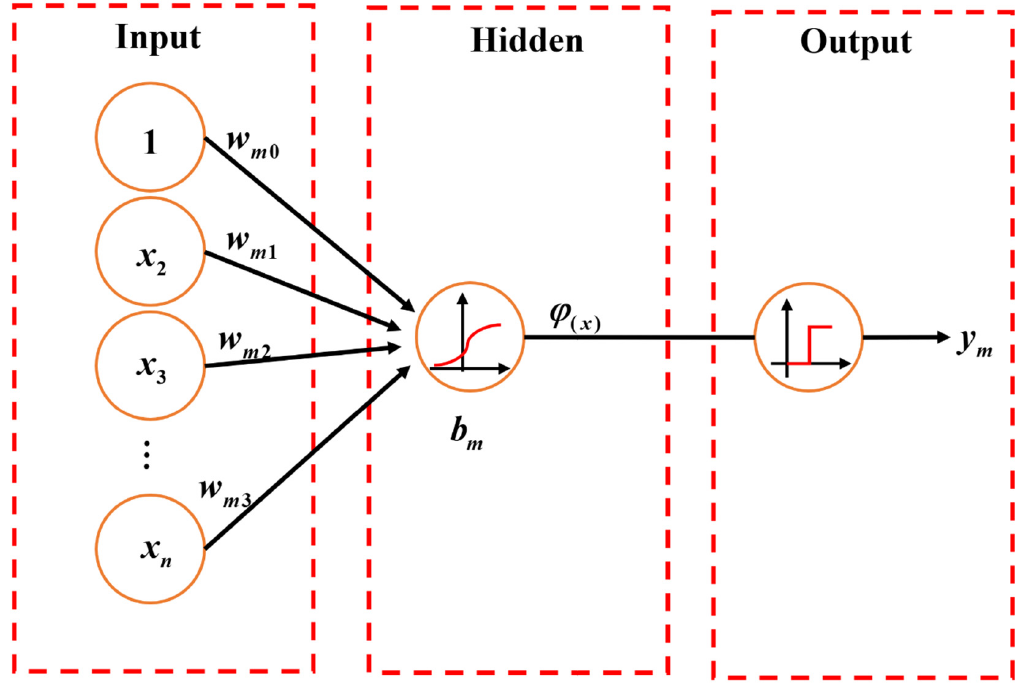
Figure 4. Architecture of ANN.